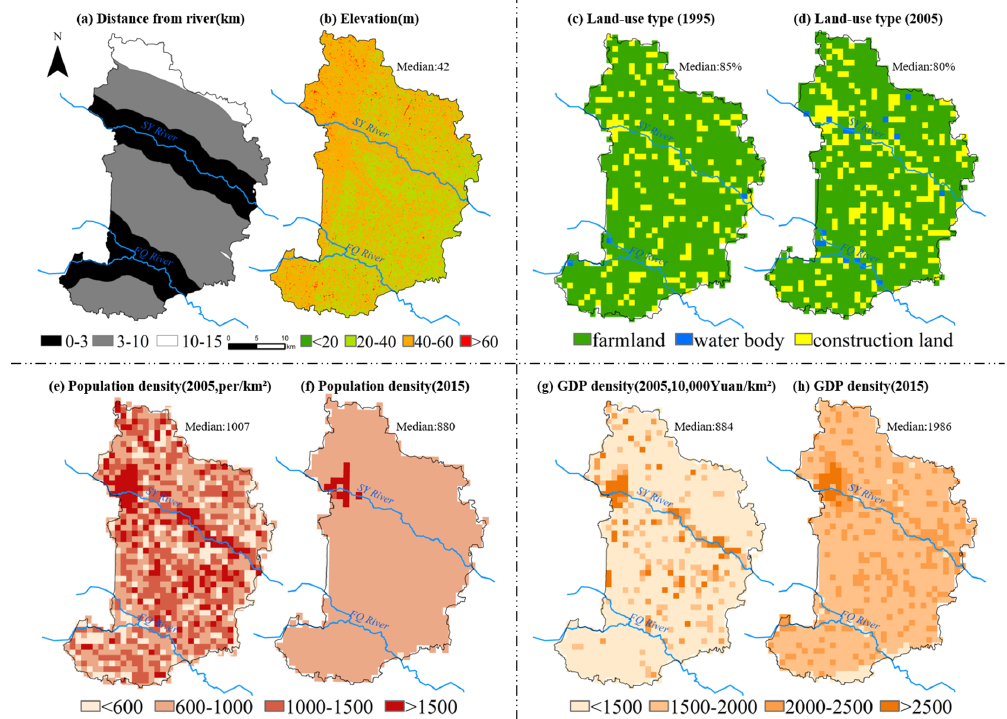
Figure 2 . Five environment proxy variables of S County, including ( a ) distance from the river; ( b )